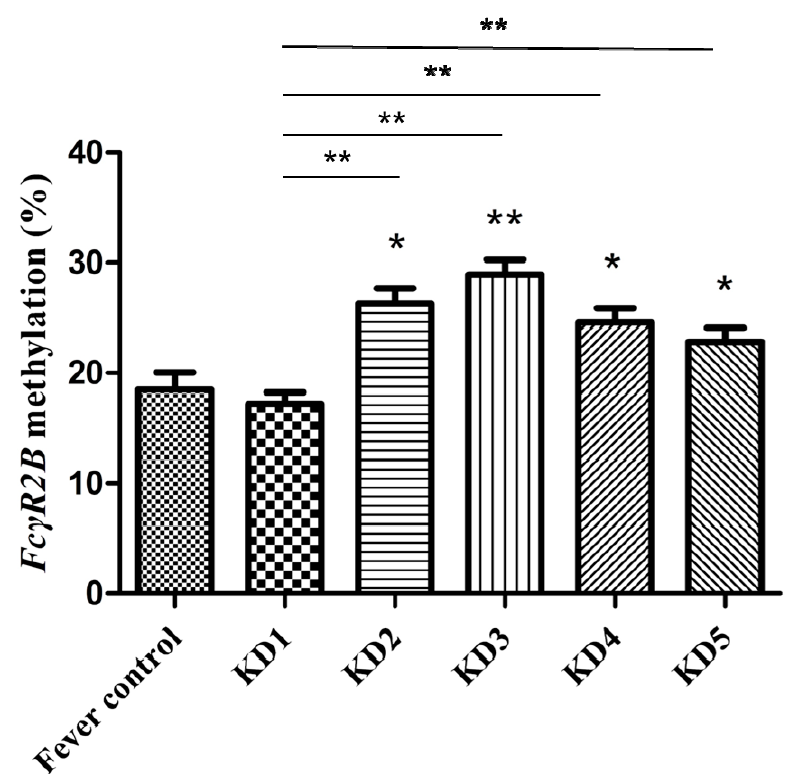
Figure 3. Prior to therapy, Fc γ R2B methylation did not differ significantly between Kawasaki disease (KD) and controls. After receiving intravenous immunoglobulin (IVIG) treatment, Fc γ R2B methylation increased and could last up to one year later. * denotes significance (* p < 0.05, ** p < 0.001). KD1, within 24 h prior to IVIG treatment; KD2, 3–7 days after IVIG; KD3, three weeks after IVIG, KD4, six months after IVIG; KD5, one year after IVIG.